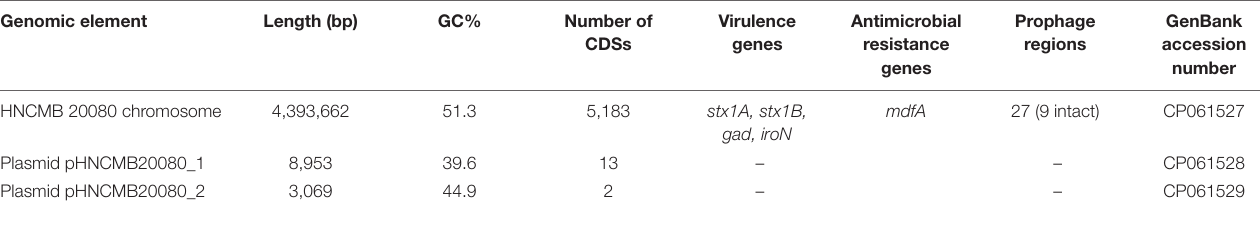
TABLE 2 | List of genomic features of Shigella dysenteriae serotype 1 strain HNCMB 20080. Genomic